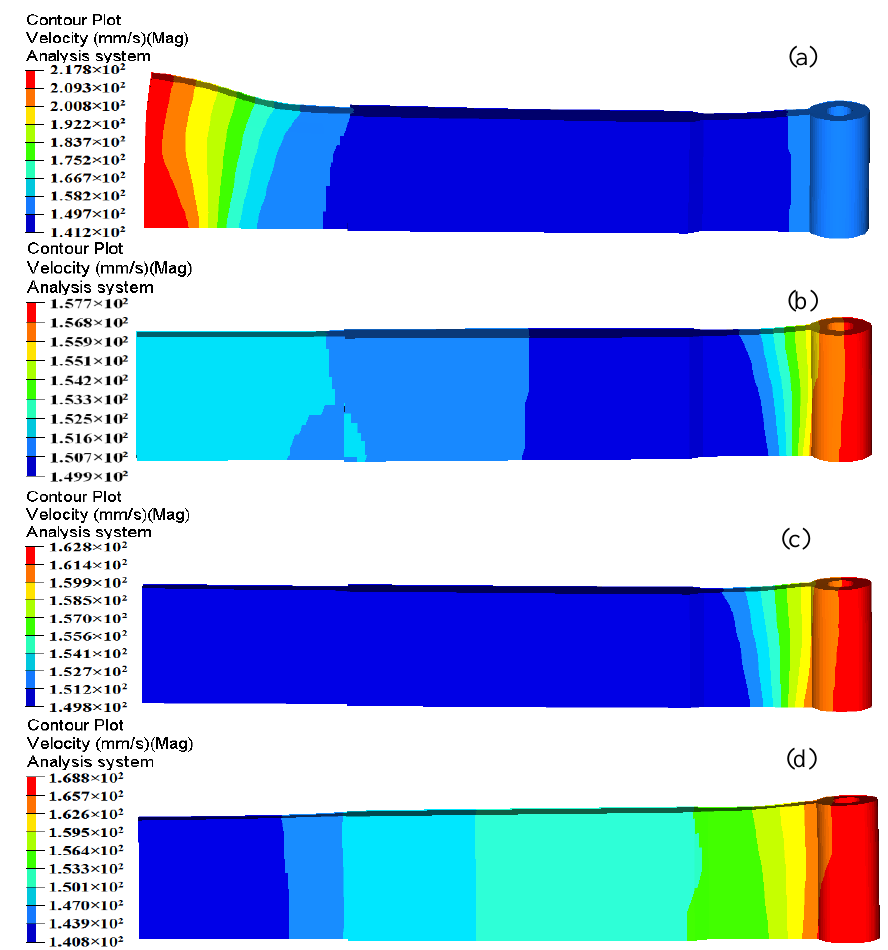
Figure 13. Velocity distribution in the extruded profiles at different positions of baffle plates: ( a ) d = 55 mm; ( b ) d = 57.5 mm; ( c ) d = 60 mm; ( d ) d = 65 mm. Table 3. Comparison of maximum and minimum velocities, SDVs, and displacements of extruded profiles at different position of baffle plates.